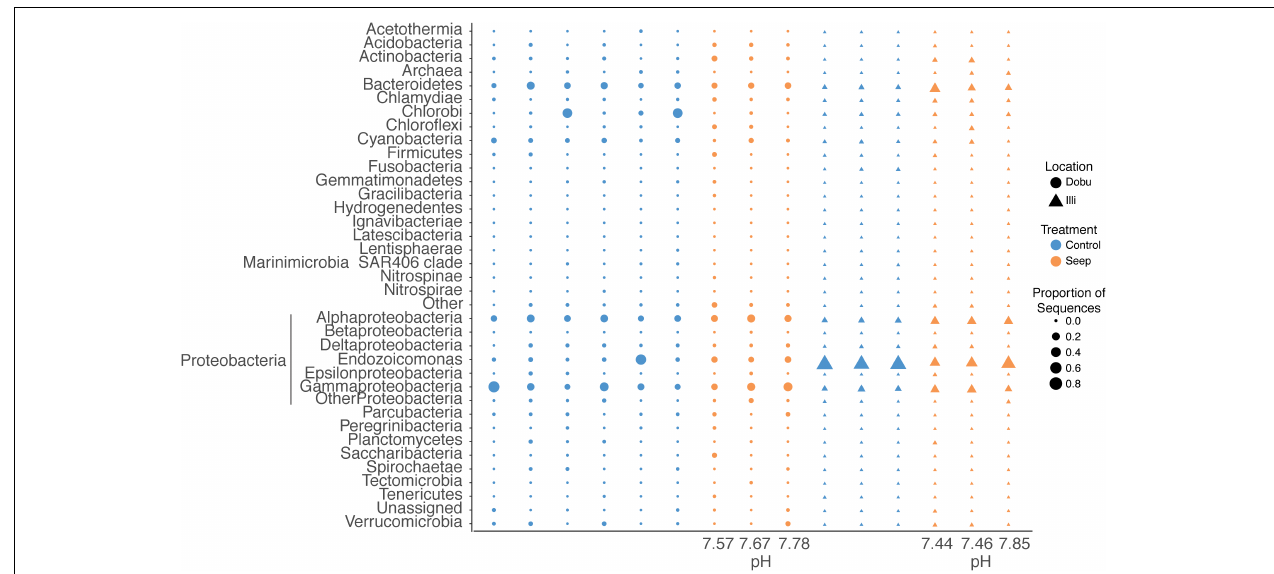
FIGURE 5 | Relative abundance of the 37 microbial phyla associated with massive Porites spp. at seep and control sites at Illi and Dobu reefs. “ Other” represents all that could not be classified below Kingdom level. “Archaea” represents all sequences affiliated to this domain. “Unassigned” represents all sequences that could not be assigned taxonomy. Sequences affiliated with Proteobacteria are split into classes ( Alphaproteobacteria, Betaproteobacteria, Deltaproteobacteria, Epsilonproteobacteria, and Gammaproteobacteria ) and genus ( Endozoicomonas ) to display higher resolution of dominant taxa associated with this phylum. Values below each column represent the pH value of each coral skeleton collected from the seep sites as analyzed by 14 C